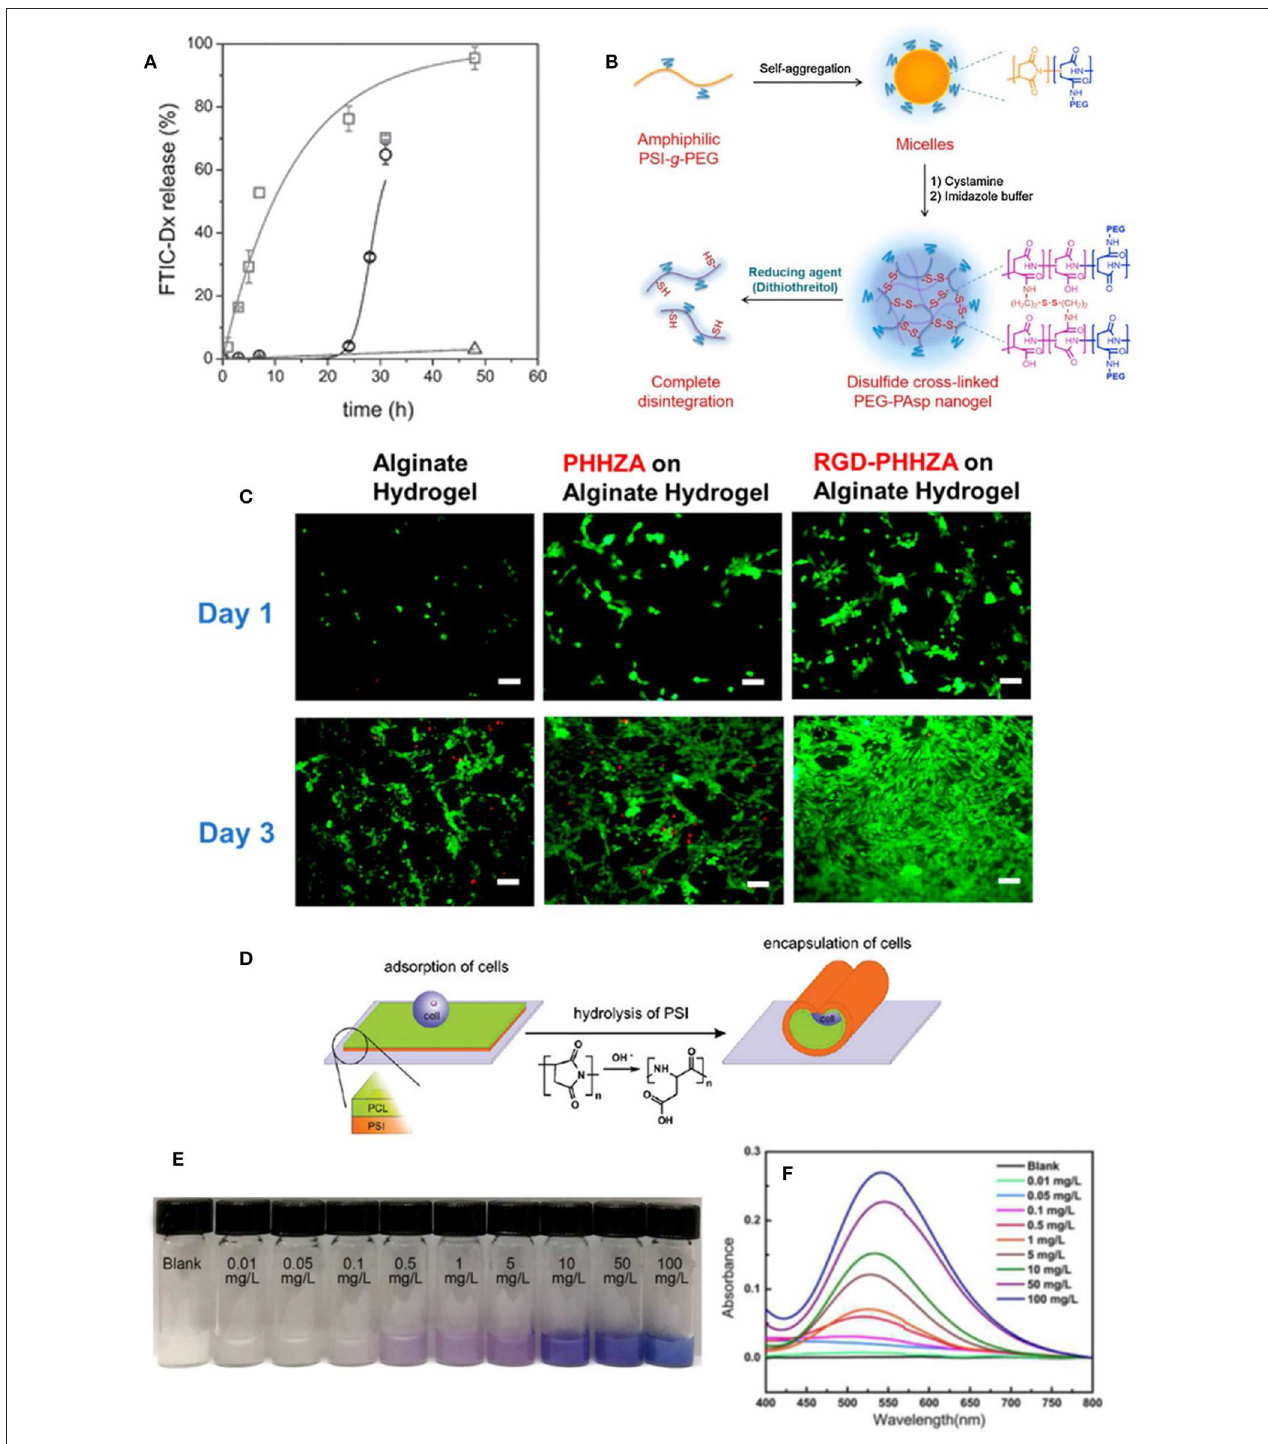
FIGURE 6 | Biomedical and industrial applications of PASP-based hydrogels. (A) FITC-Dx release from PASP nanogels as a function of time and DTT concentration (squares: 100 × 10 − 3 M, spheres: 10 × 10 − 3 M, and triangles: 0 × 10 − 3 M DTT). Reproduced from Krisch et al. (2016) with permission from Wiley. (B) Synthesis of the disulfide cross-linked PASP nanogel and its complete disintegration by reducing agent. Reproduced from Park et al. (2017) from Elsevier. (C) The live (green) and dead (red) cells cultured on alginate, alginate/poly(2-hydroxyethyl-co-hydrazidoadipoyl aspartamide) (PHHZA), and alginate/RGD-PHHZA hydrogels after 1 and 3 days (scale bar: 100 µ m). Reproduced from Jang and Cha (2018) with permission from American Chemical Society. (D) The schematic illustration of cell encapsulation by bilayer PSI/PCL tubes. Reproduced from Zakharchenko et al. (2011) with permission from American Chemical Society. (E) Color change and (F) absorption spectra of PASP in different Cu 2 + ions solution. Reproduced from Zhang et al. (2015) from with permission Elsevier.